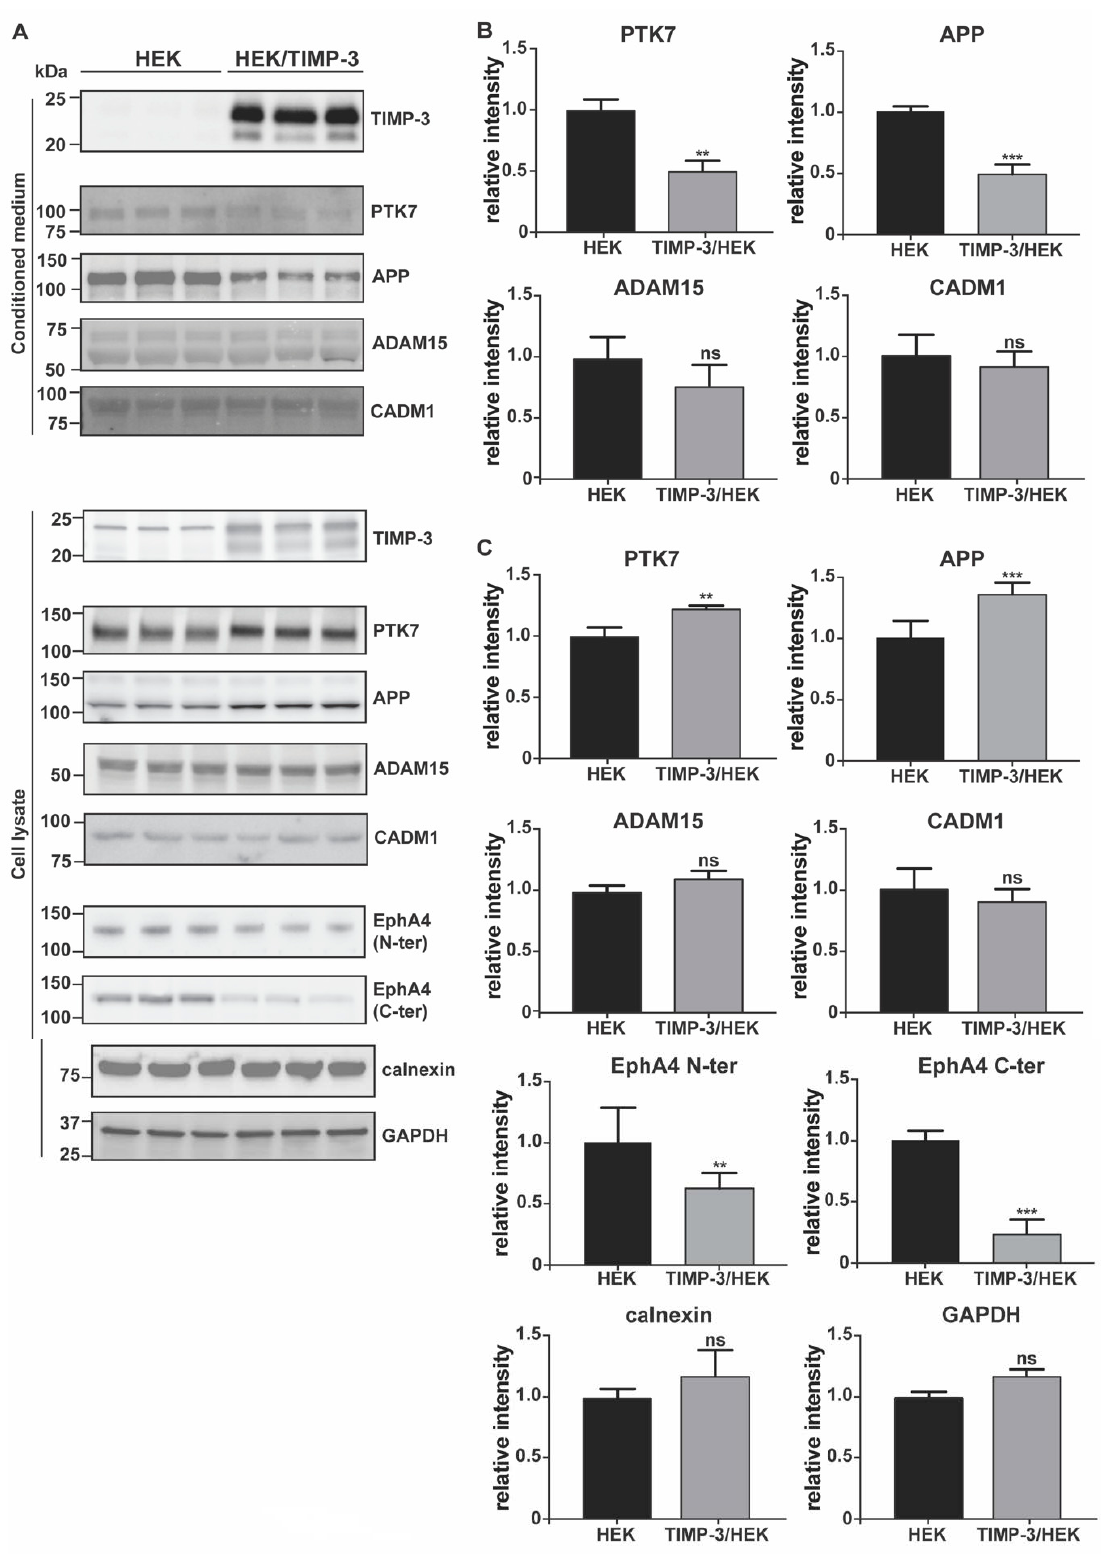
Figure 2 . Analysis of protein changes by immunoblotting. ( A ) Immunoblots showing protein abundance of TIMP-3, PTK7, APP, ADAM15, and CADM1 in the conditioned media of TIMP-3/HEK and control HEK 293 cells, as well as levels of PTK7, APP, ADAM15, CADM1 and EphA4 in the cell lysates. Calnexin and GAPDH were used as loading controls. Densitometric quantifications of specific proteins in the conditioned media ( B ) and cell lysates ( C ) are displayed as mean values ± standard deviation (** p < 0.01, *** p < 0.005, Student’s t -test; from 3 to 6 separate experiments have been performed and